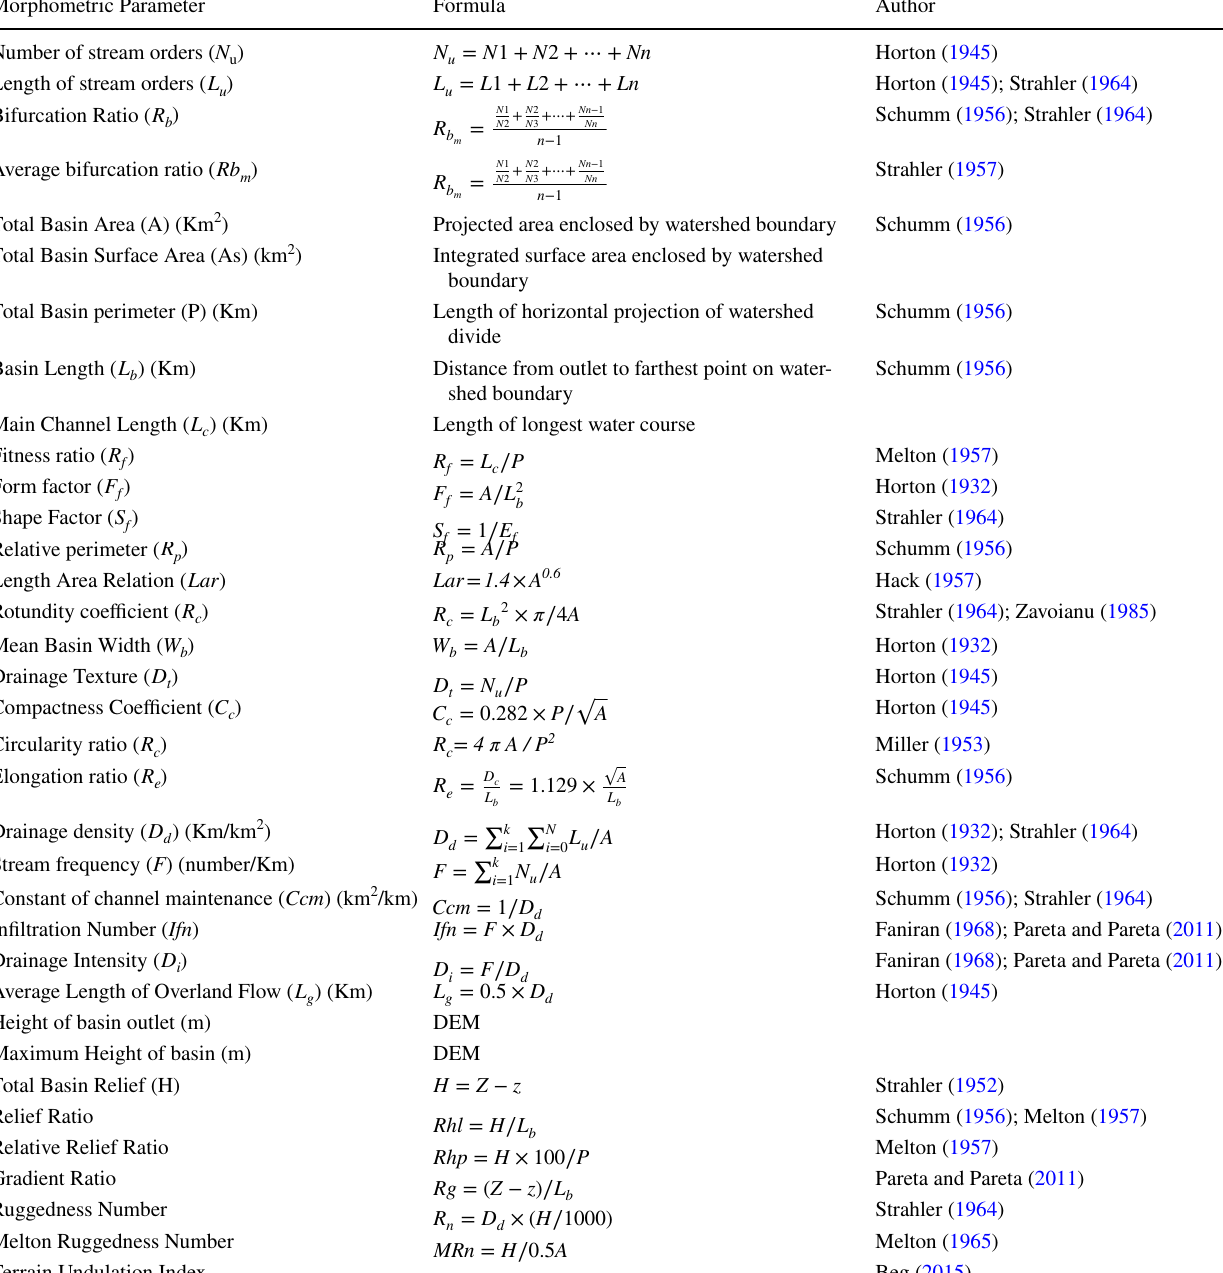
Table 1 Morphometric parameters and their formulae Morphometric Parameter